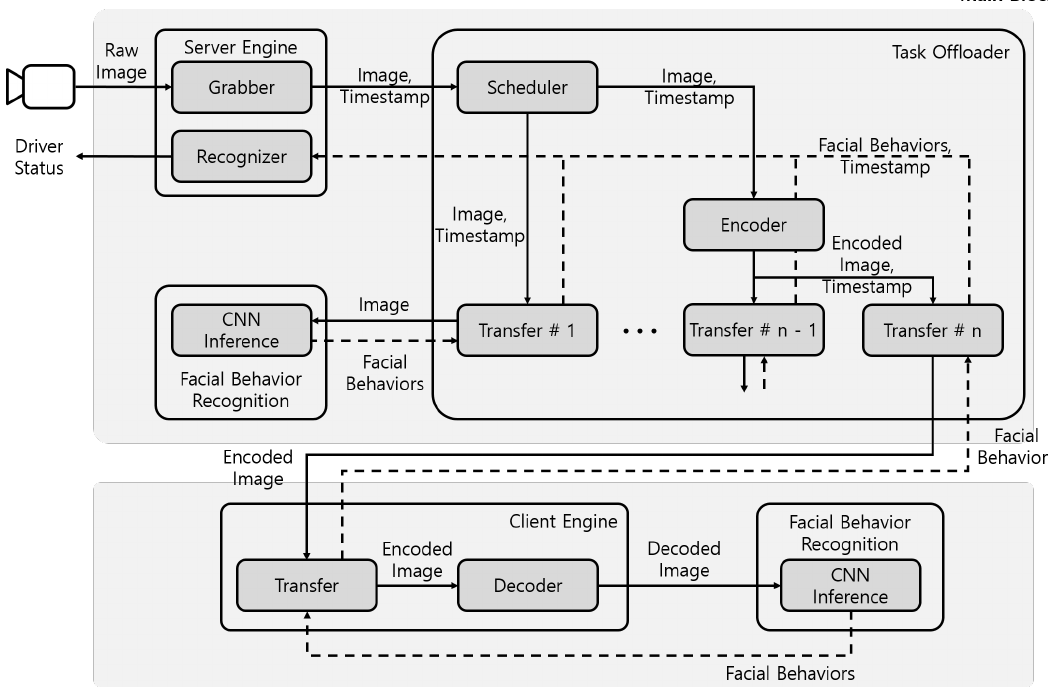
Figure 9. Configuration of the proposed